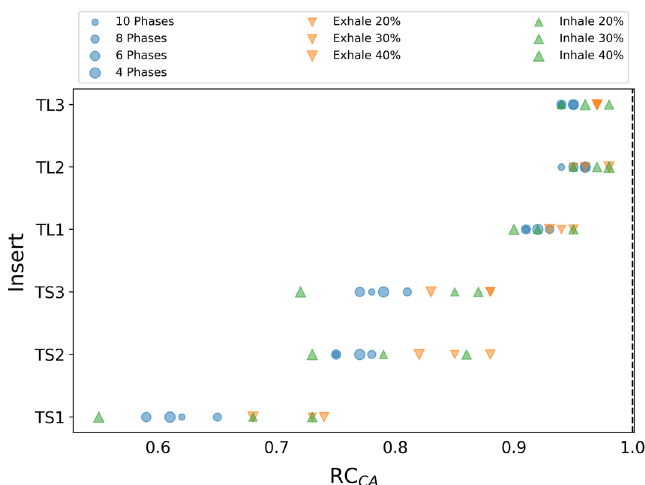
Fig. 10 Average of the activity concentration RC of the three movements for each lesion